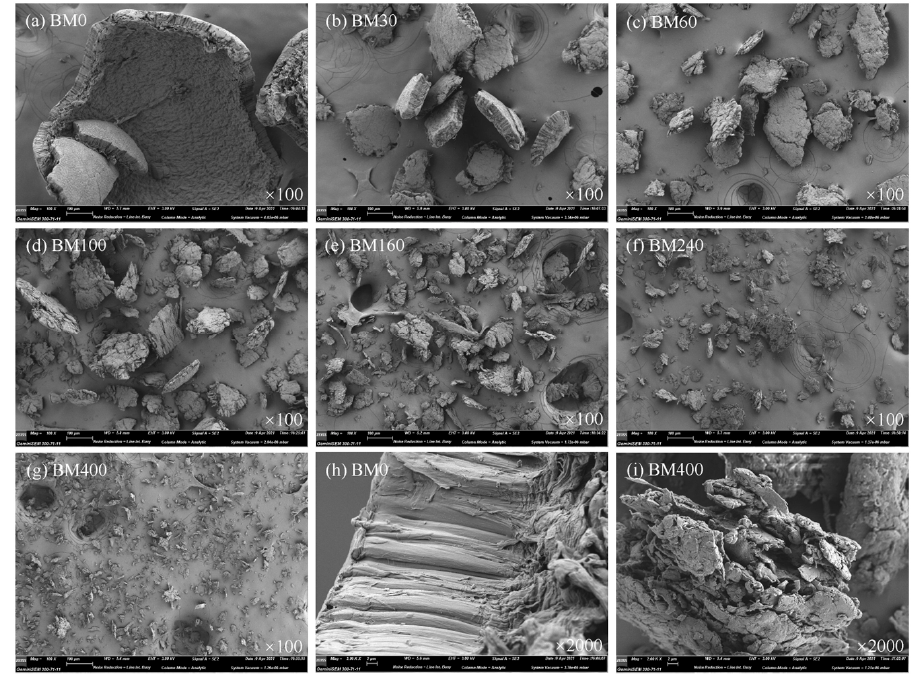
Figure 2. SEM images of PIDF samples at different scales.